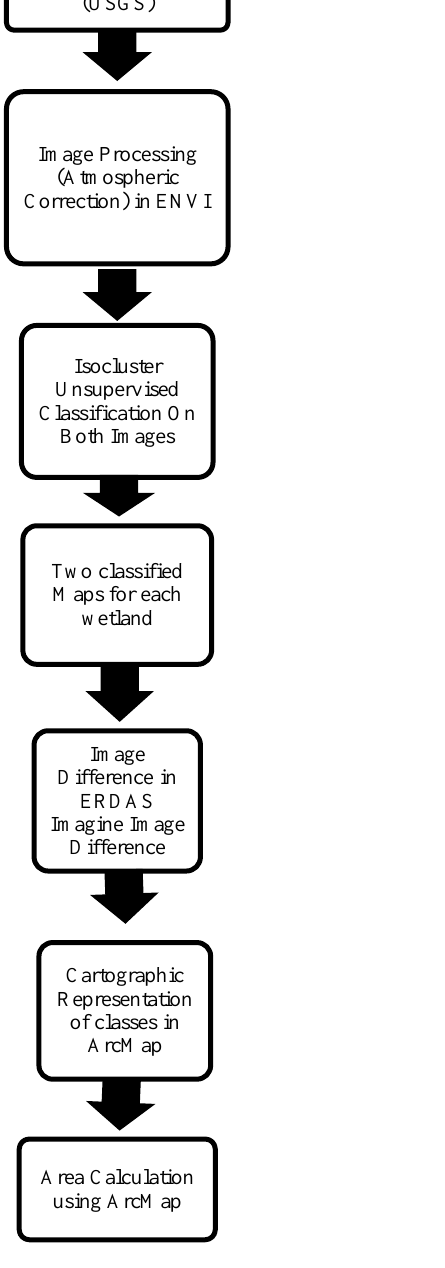
Figure 2. Methodology flow chart